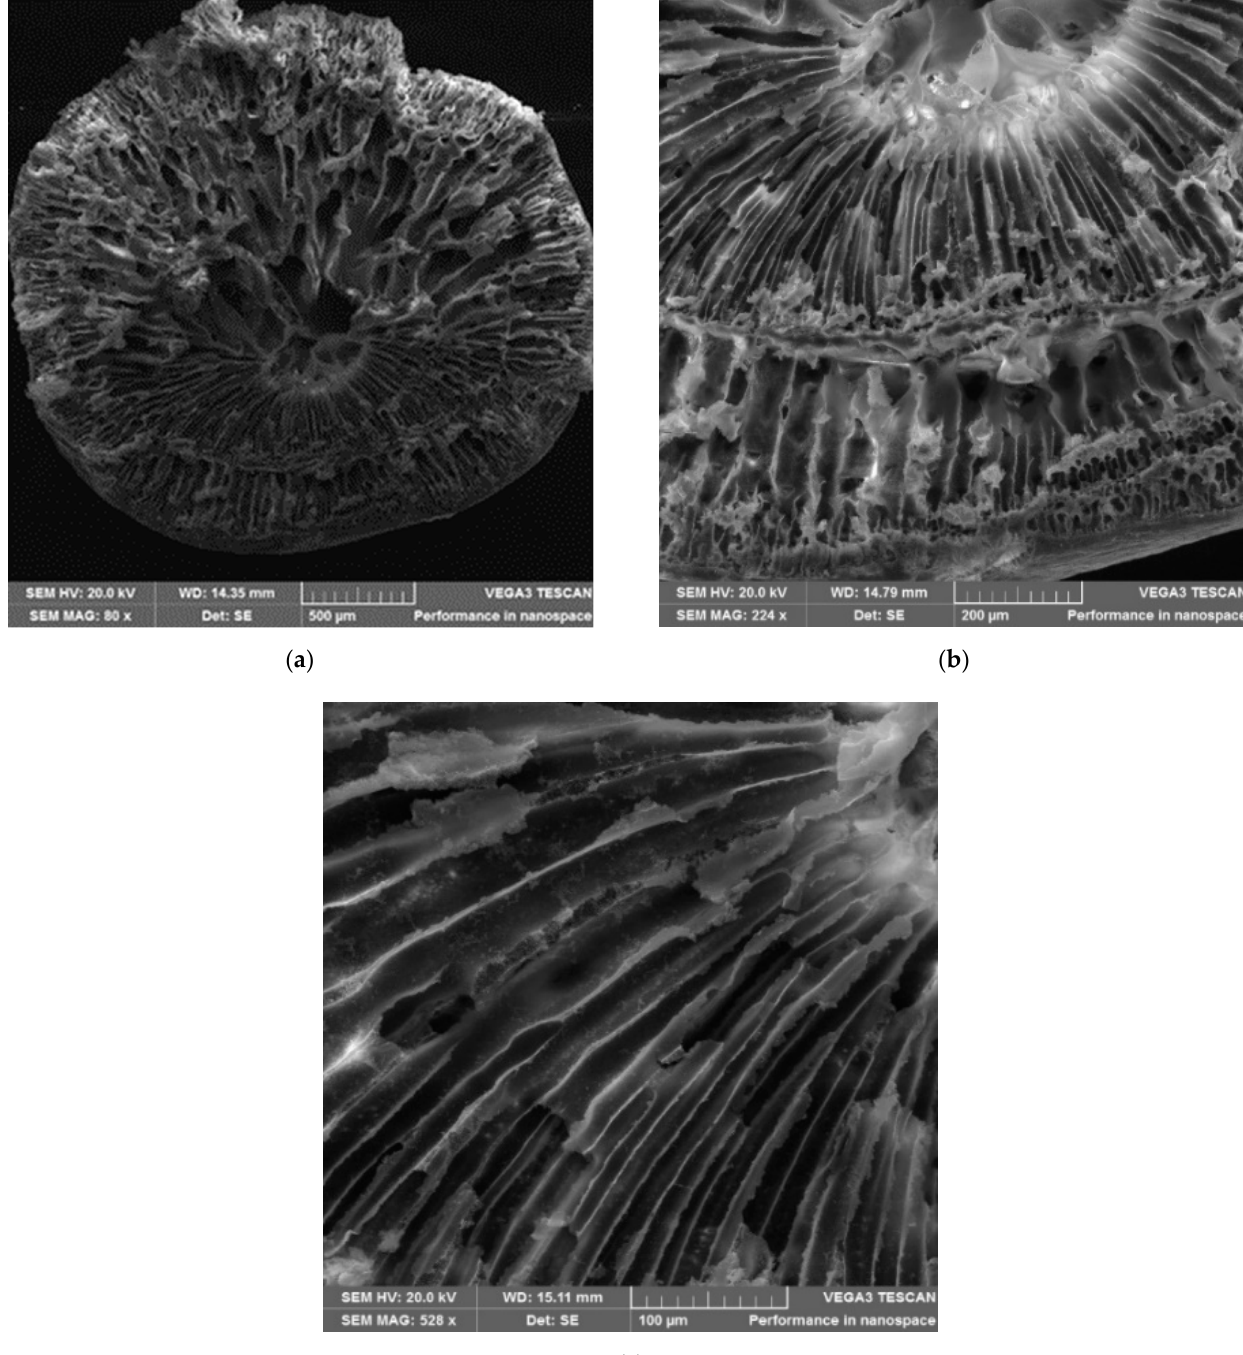
Figure 3. Scanning electron microscope (SEM) images of the internal porous network of a mesoporous neat PAN monolith: ( a ) image showing the entire porous network of the spherical monolith; ( b ) image highlighting the various pore sizes and morphologies within the monolith; ( c ) a close-up image of finger-like pores in the center of the monolith.